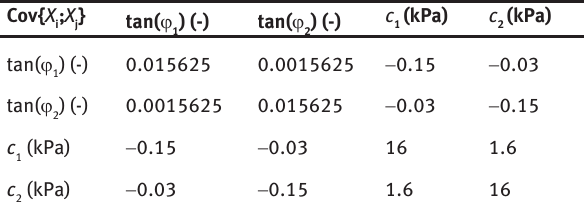
Table 1: Auto- and cross-covariances used in numerical calculations.